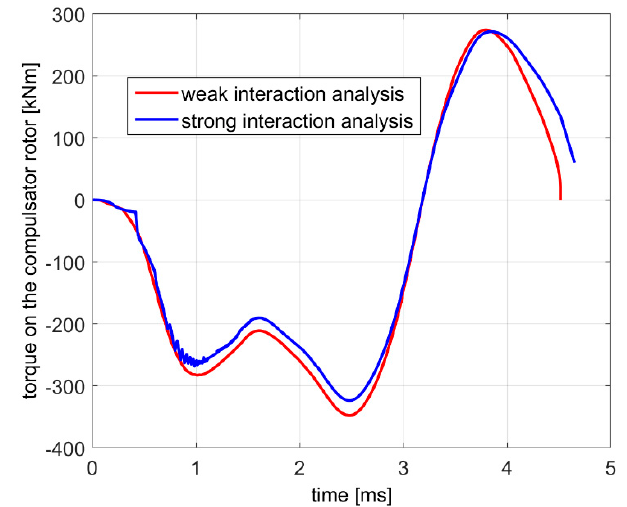
Figure 13. The torque on the rotor of the compulsator. The portion of the curve with positive value corresponds to recovering of magnetic energy as kinetic energy.